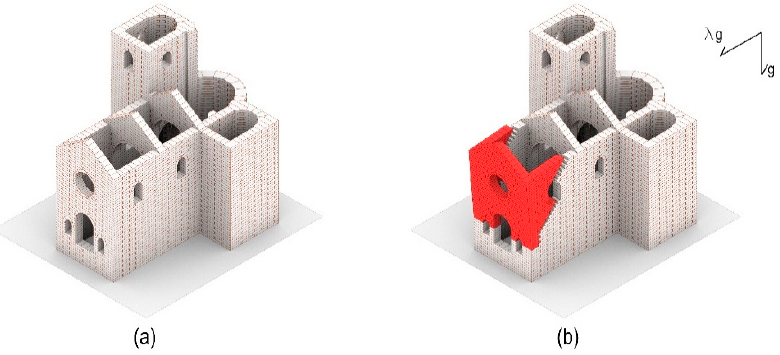
Figure 9. ( a ) Geometry configuration; ( b ) failure mechanism obtained by using non-associative